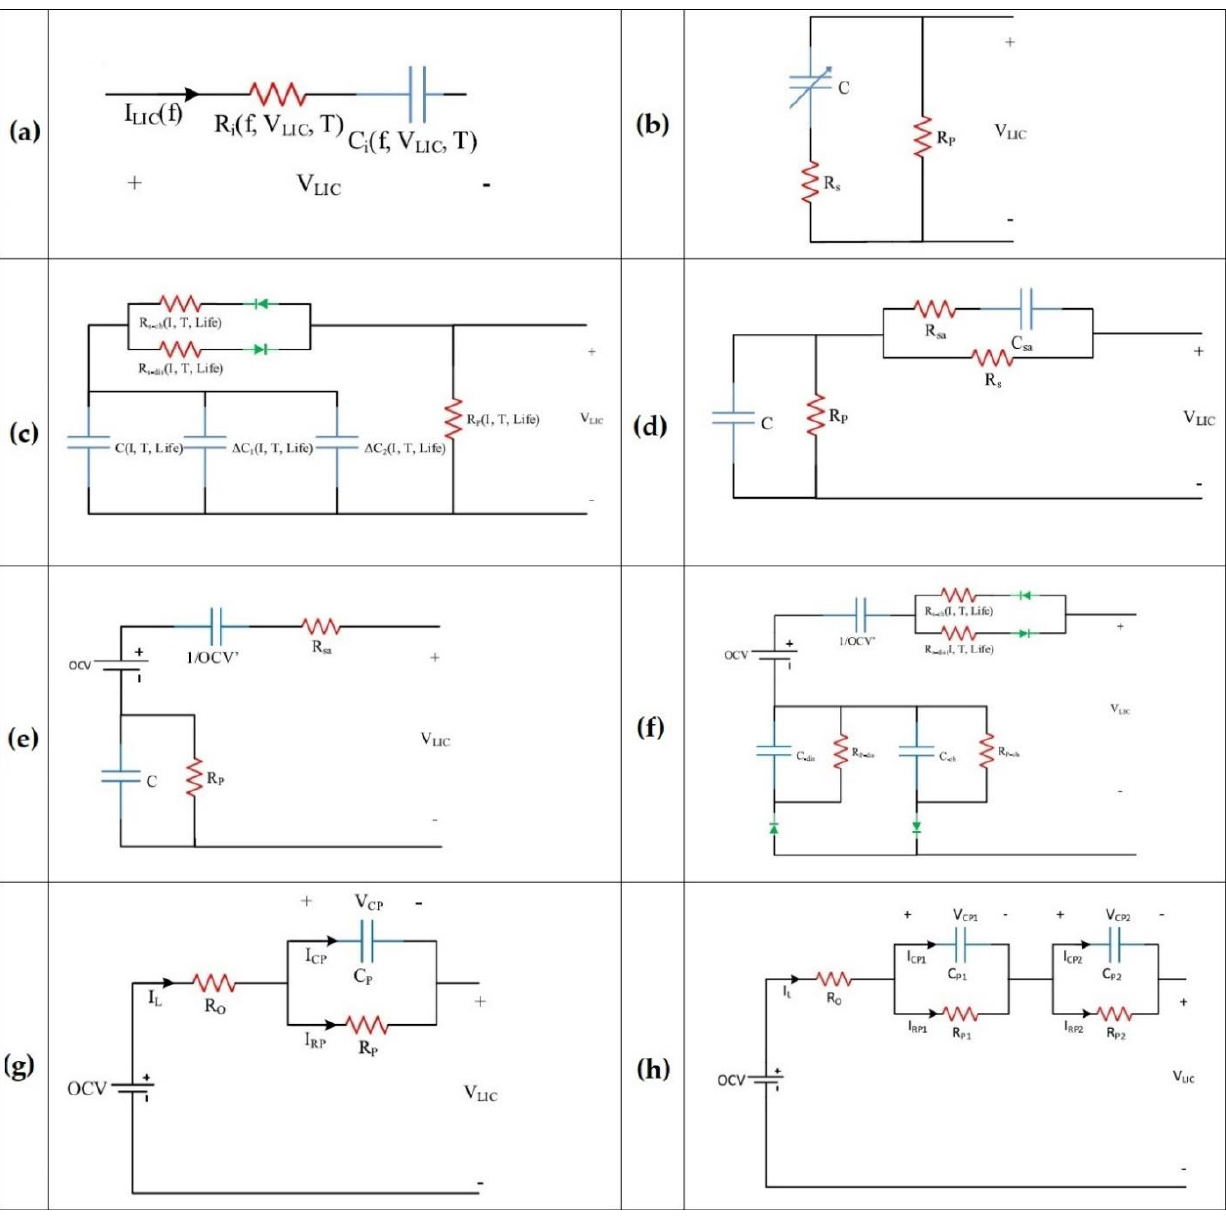
Figure 8. The developed ECMs for the LiC technology [26]: ( a ) R int , ( b ) R int -R p , ( c ) Advanced R int -R p , ( d ) Hybrid, ( e ) PNGV (Partnership for New Generation of Vehicles), ( f ) Advanced PNGV, ( g ) Thevenin, ( h ) 2-RC.